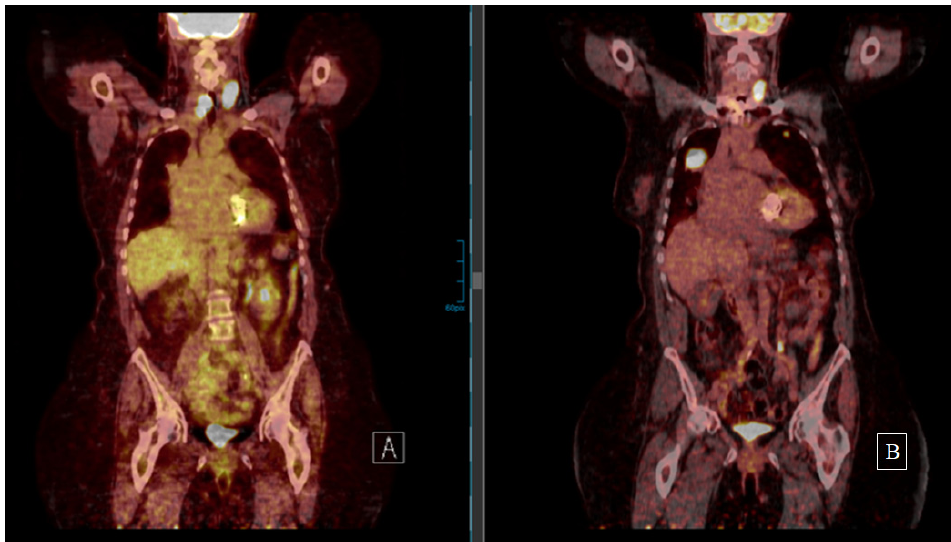
Figure 2. Patient 5 underwent resection of a cervical FTC recurrence diagnosed 5 years after thy- roidectomy despite bilateral lung metastases (18F-FDG PET on the left side ( A )). Cervical and thorax EBRT were performed. The 18F-FDG PET on the right ( B ) (5 years after the second cervical resection and 10 years after first FTC diagnosis) shows both cervical and lung progress. After thorough patient information concerning the evidence on tyrosine kinase inhibitors, the patient refused treatment and was progressing at last